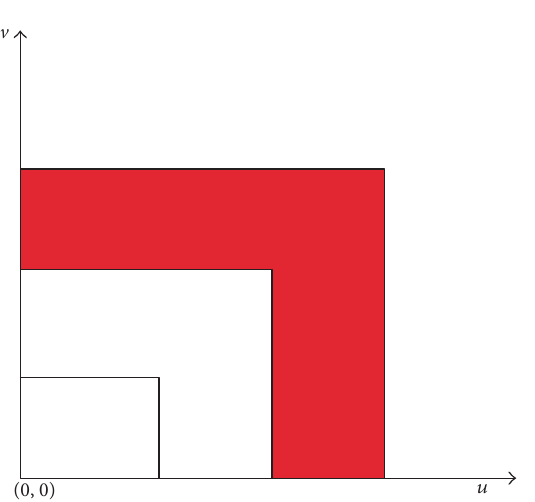
Figure 4: The high frequency DCT subband in red shaded region is used to create 𝑅 1 (𝑥,𝑦) . The coordinate (0,0) is the DC coefficient.